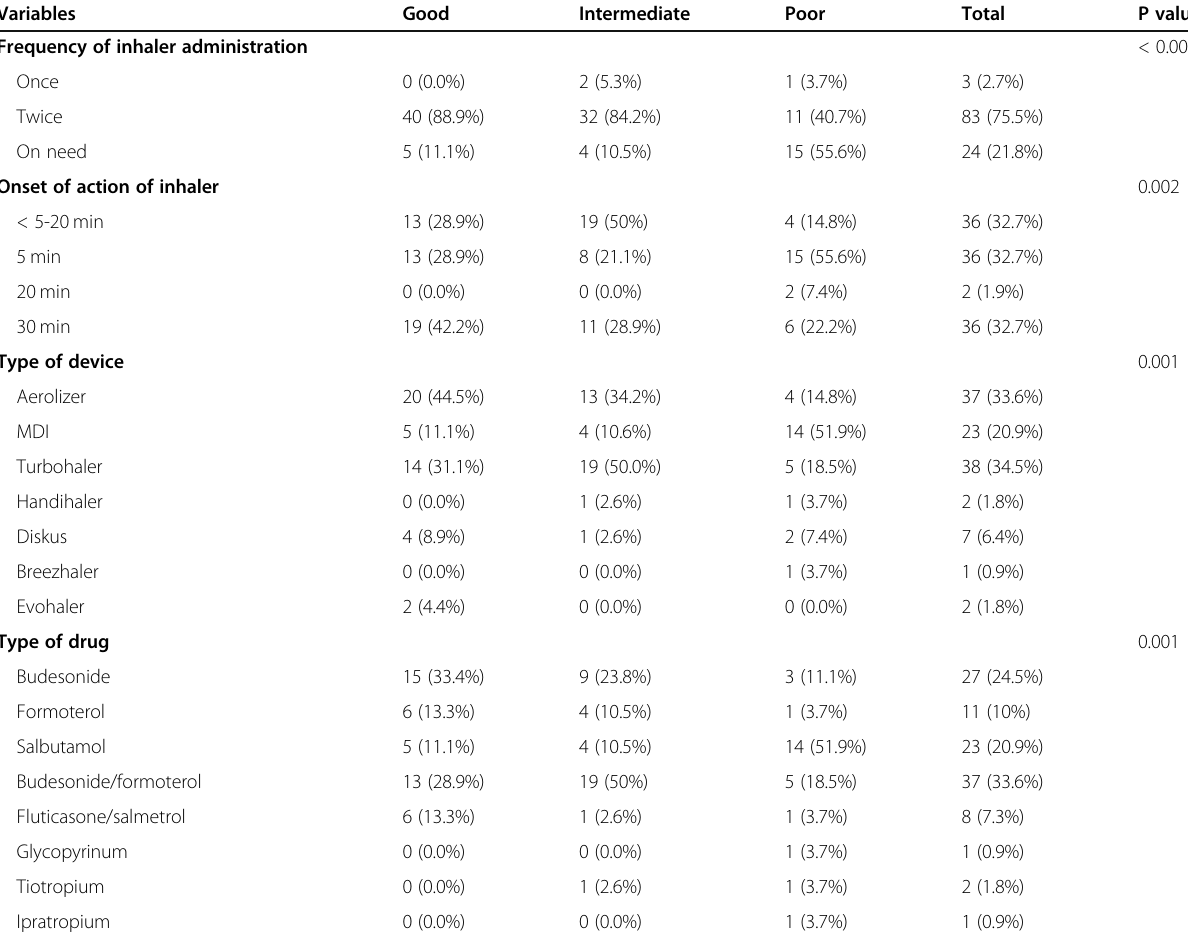
Table 3 Relation between drug characteristics and adherence pattern in asthmatic patients already on therapy ( n = 110) Variables Good Intermediate Poor